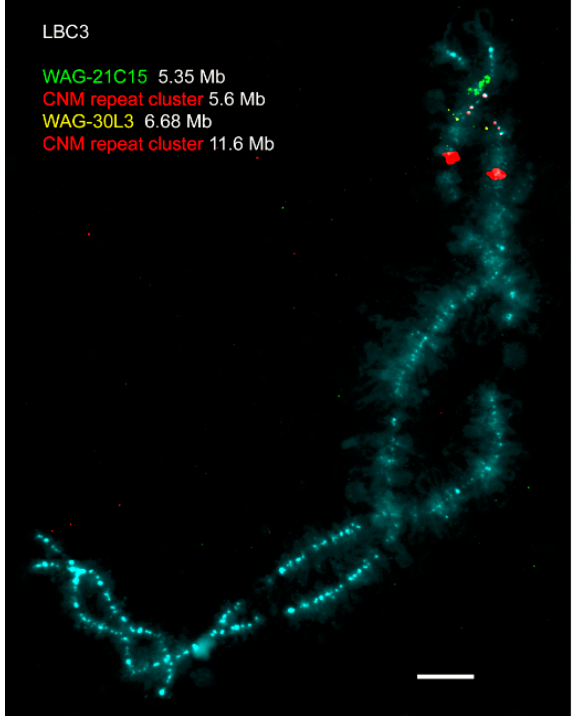
Figure 2. High-resolution FISH-mapping on avian lampbrush chromosomes (an example). FISH with chicken nuclear-membrane-associated repeat (CNM repeat)-specific probe (red) and bacterial artificial chromosome (BAC) clones WAG12C15 (green) and WAG30L03 (yellow) on chicken lampbrush chromosome 3. Chromosome is counterstained with DAPI. Scale bar = 10 µm. Chromosome coordinates of BACs and CNM clusters are given in megabases (Mb) according to the chicken genome assembly Gallus_gallus-5.0 (https://www.ncbi.nlm.nih.gov/genome/111) [26]. BACs were kindly provided by Richard Crooijmans and Martin Groenen (Wageningen chicken BAC library, Crooijmans et al., 2000 [29]). The data on precise genome positioning of the centromere and two CNM-repeat clusters from chicken chromosome 3 are published in Zlotina et al., 2010